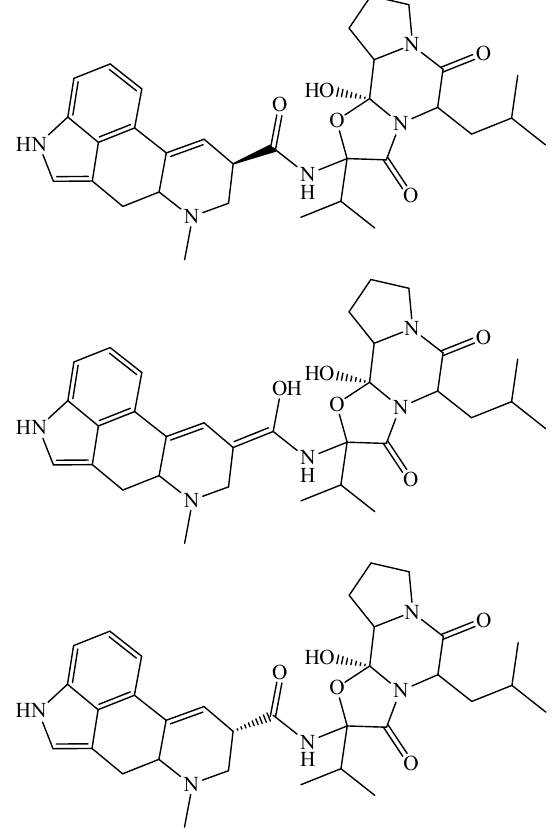
Figure 3. Different stereoisomeric forms of R - and S - α -ergocryptin and the intermediate IT ( R top, IT middle, S